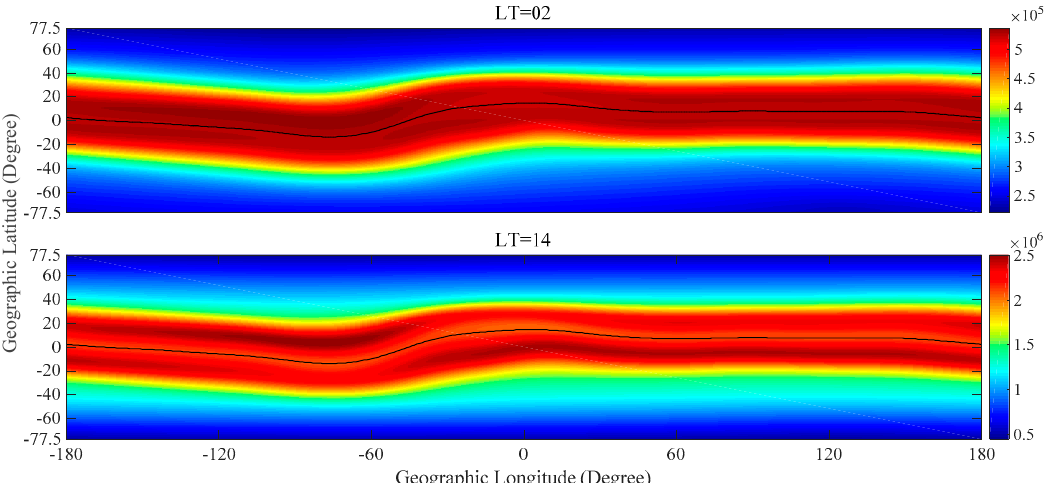
Figure 10. Same as Figure 9, but for high (F10.7 = 150 sfu) solar activity.